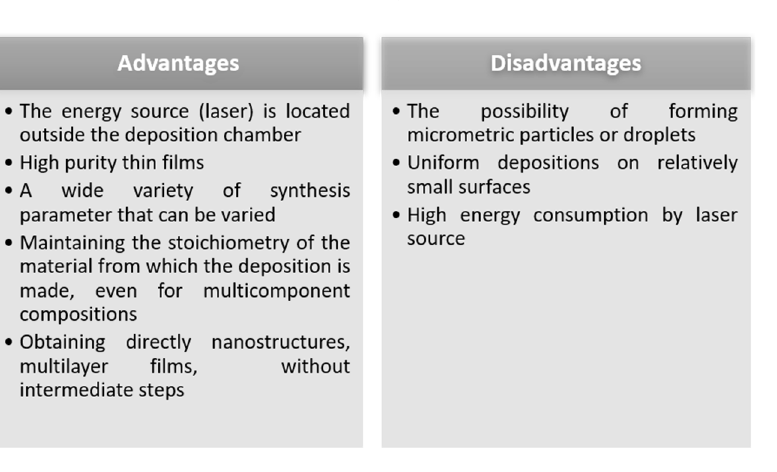
Figure 13. Advantages and disadvantages of PLD process.